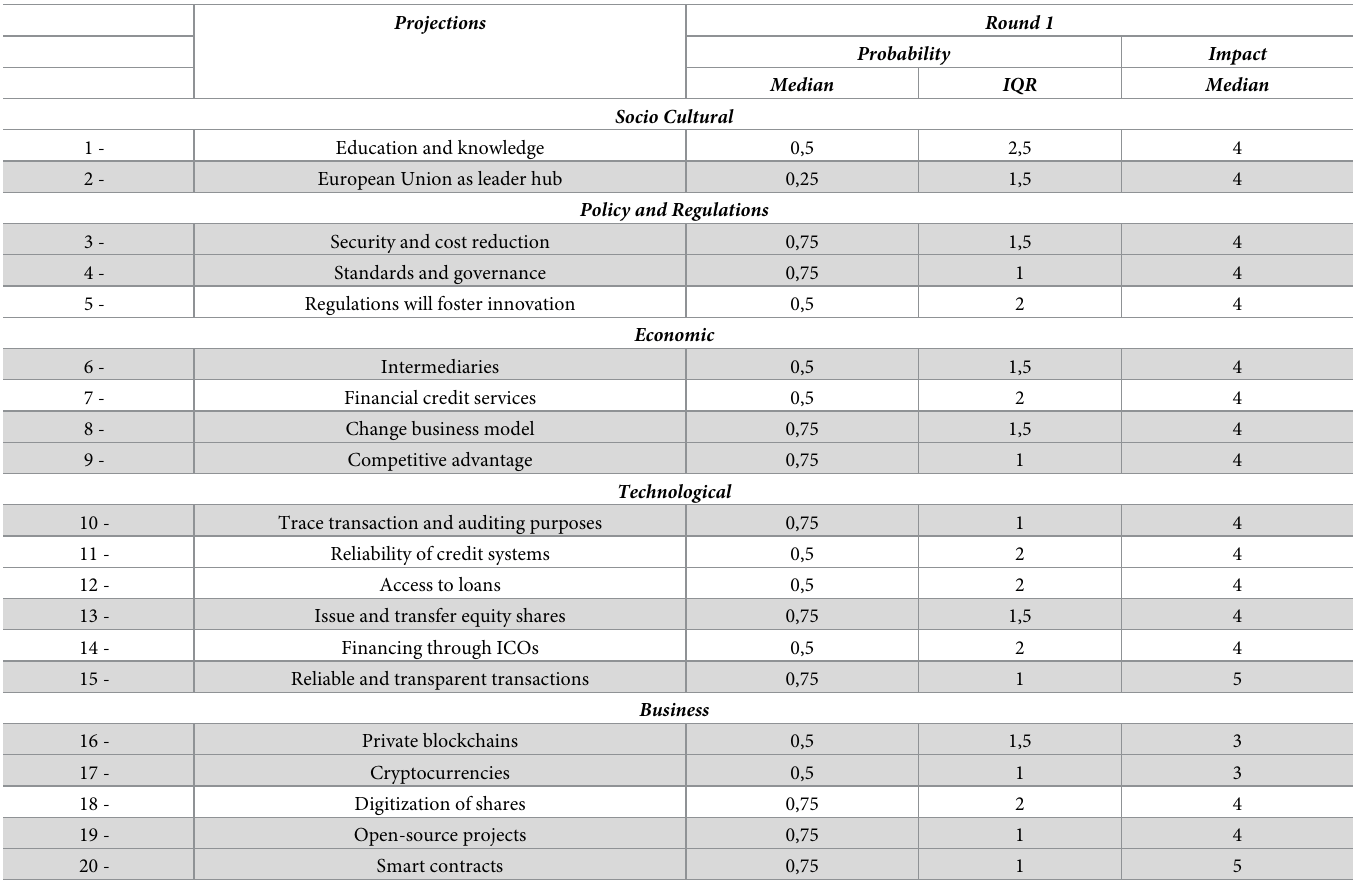
Table 3. Central tendency measures for the first round of